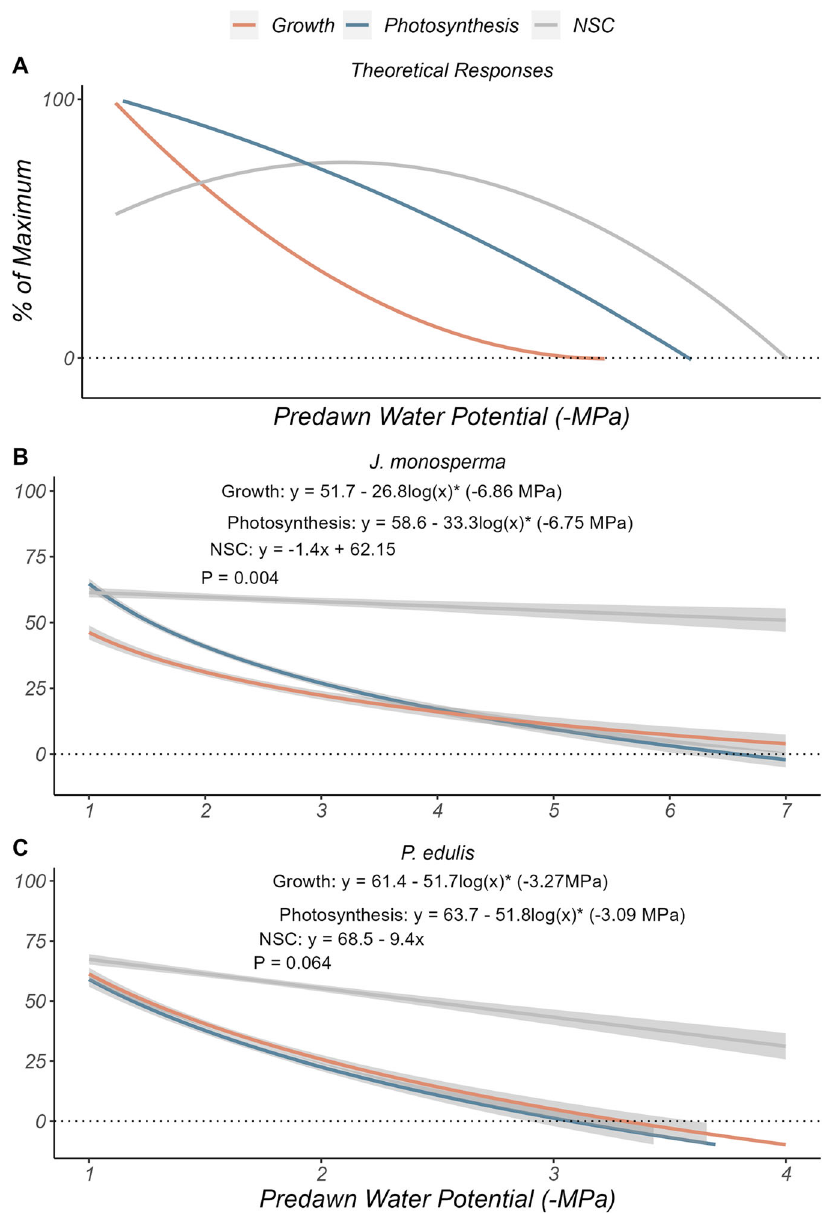
Fig. 1 | No carbon storage for growth-limited trees. Growth and photosynthesis are co-limited as ψ pd declines ( B () and C ). The expected increase in NSC accu- mulation as growth becomes constrained by drought is subverted given the rapid decline in photosynthesis. A The theoretical response of growth, photosynthesis, andNSCisshownbasedonpredictionsfromtheory 1 . B , C Theobservedresponseof growth, photosynthesis, and canopy NSC to drought suggests this theory may not apply to mature trees living in semi-arid environments. Lines in ( A ) re fl ect a loess smooth function. B , C Lines re fl ect point estimates of the regression coef fi cient fromalinear-logandlinearmodel fi tatthespecieslevel,whilelimitationthresholds